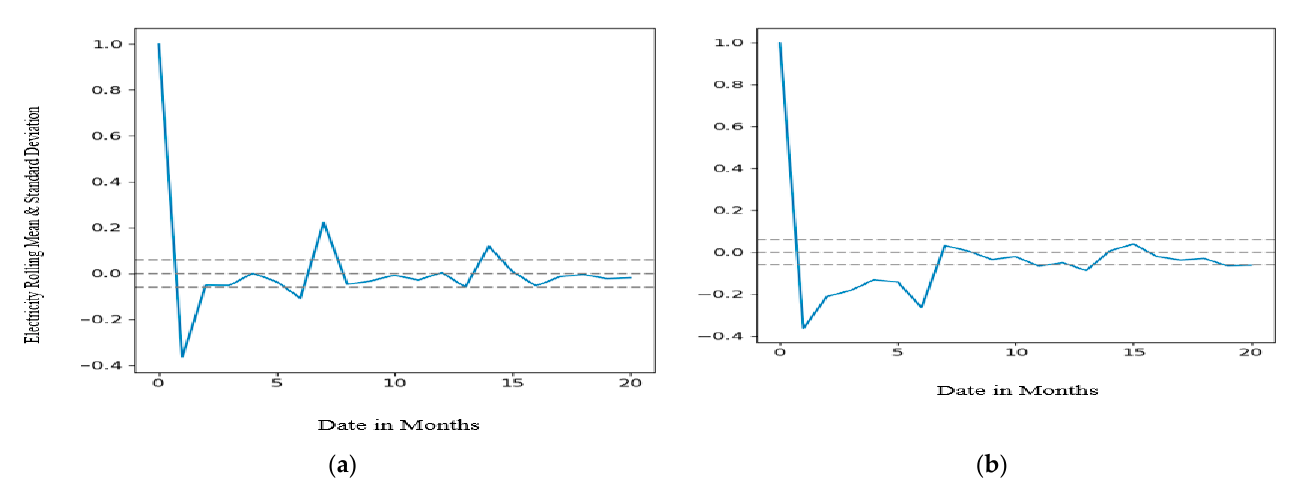
Figure 5. Test results: ( a ) autocorrelation ( b ) partial autocorrelation.